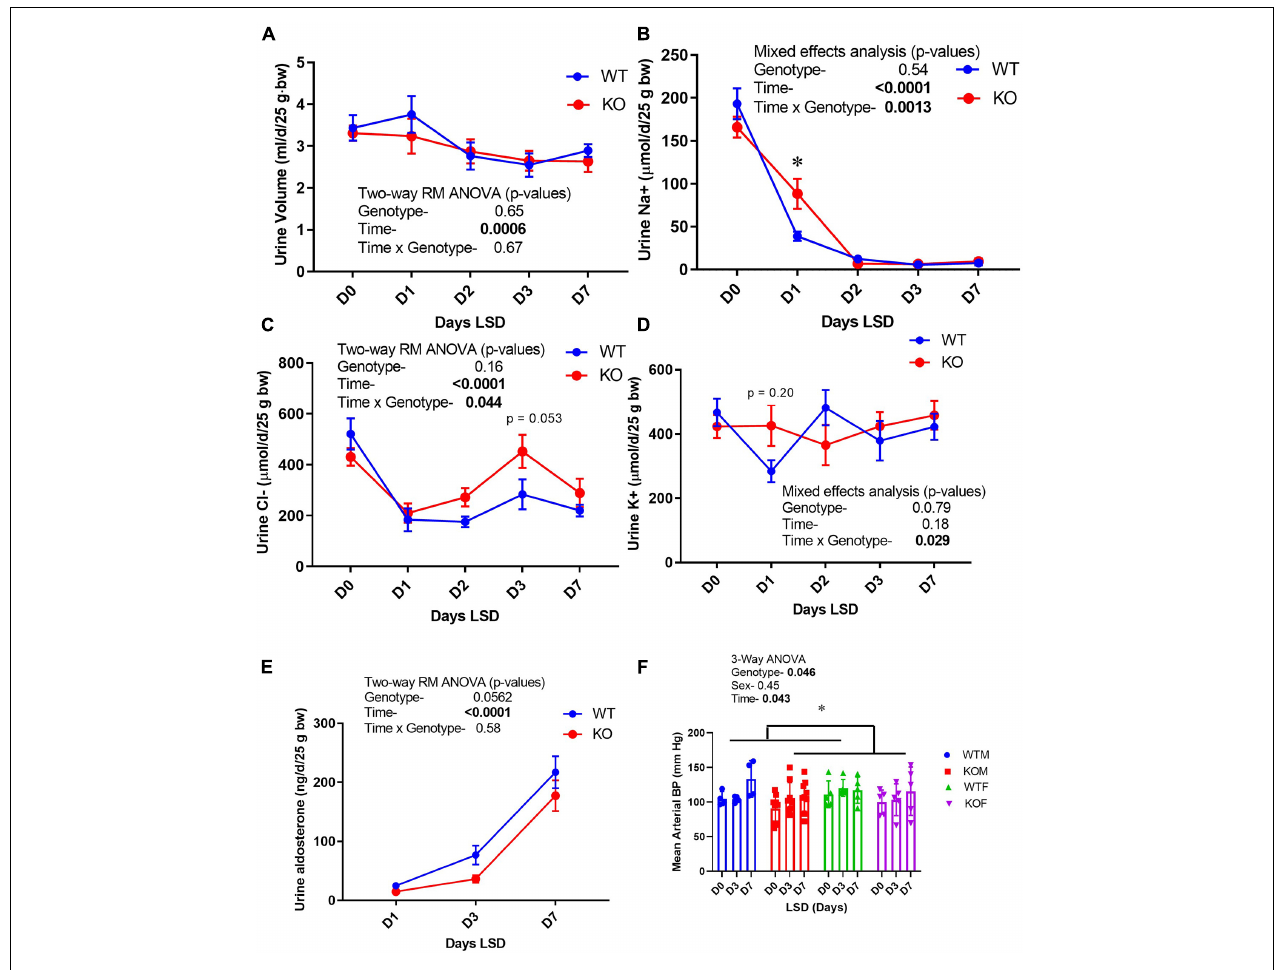
FIGURE 3 | Urine electrolyte excretion, blood pressure, and urine aldosterone under normal and low- Na+ diet. Urine (24 h) was collected on male mice in metabolic cages first under normal diet (D0) and then under 7 days of low- Na+ diet (LSD). Blood pressure (in both sexes) was recorded on a separate group of mice in the baseline and after 3 and 7 days of LSD. Mice were taken out of cages to reduce stress on days 5–6. Volume was recorded and electrolyte concentrations and aldosterone determined on urine and expressed as total excreted per day (d) normalized to 25 g body weight. (A) urine volume; (B) urine Na+ (volume × concentration); (C) Cl − ; (D) K+, (E) aldosterone excretion patterns; (F) mean arterial blood pressure (tail cuff) in WT (blue) and KO (red) mice ( n = 6 mice/genotype); results of two-way ANOVA provided in figure inset. KO mice showed attenuation in the reduction in urine Na+ on Day 1, and modestly but significantly reduced blood pressure. *indicates a significant difference due to genotype ( p < 0.05) as determined by 2-way